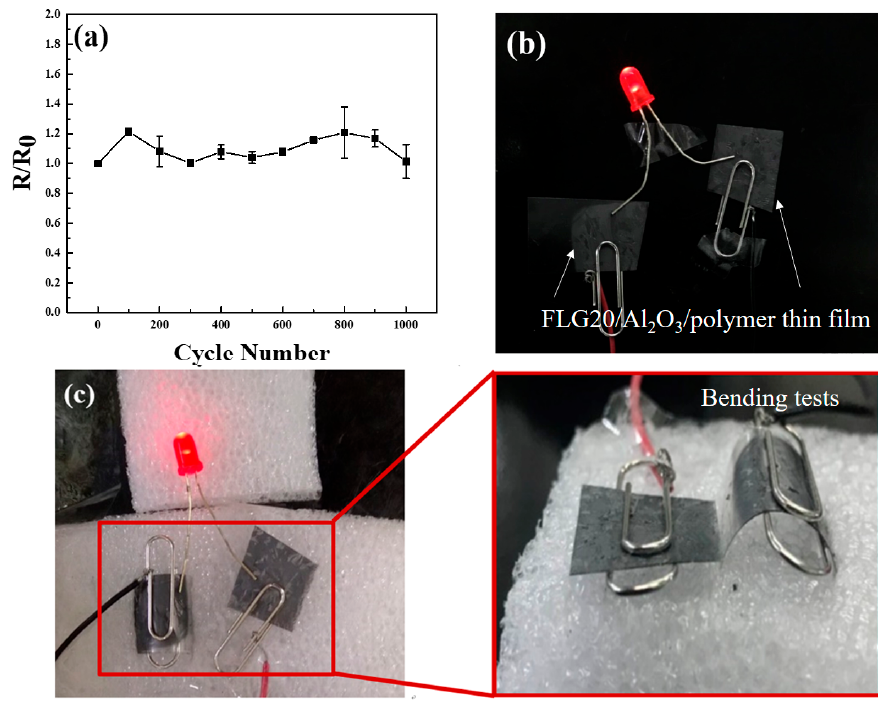
Figure 8. ( a ) The resistance increase ratio (R/R 0 ) of FLG20/Al 2 O 3 /polymer thin film on PET under a